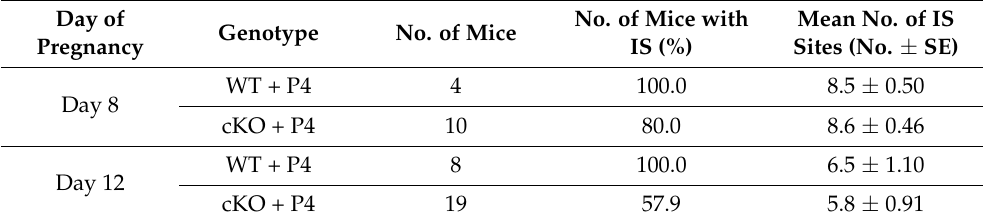
Table 2. P4 supplementation partially rescues pregnancy of cKO